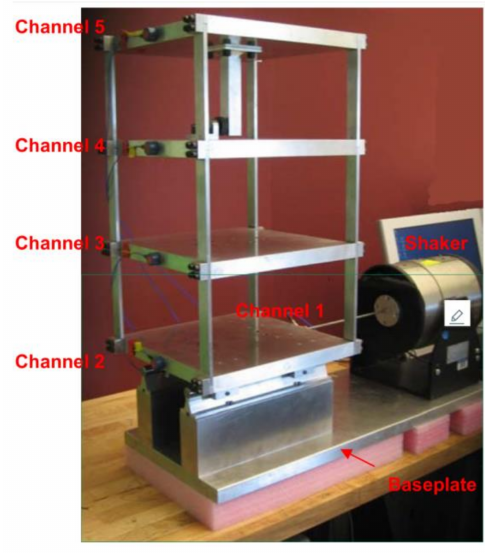
Figure 5. The three-story building structure.